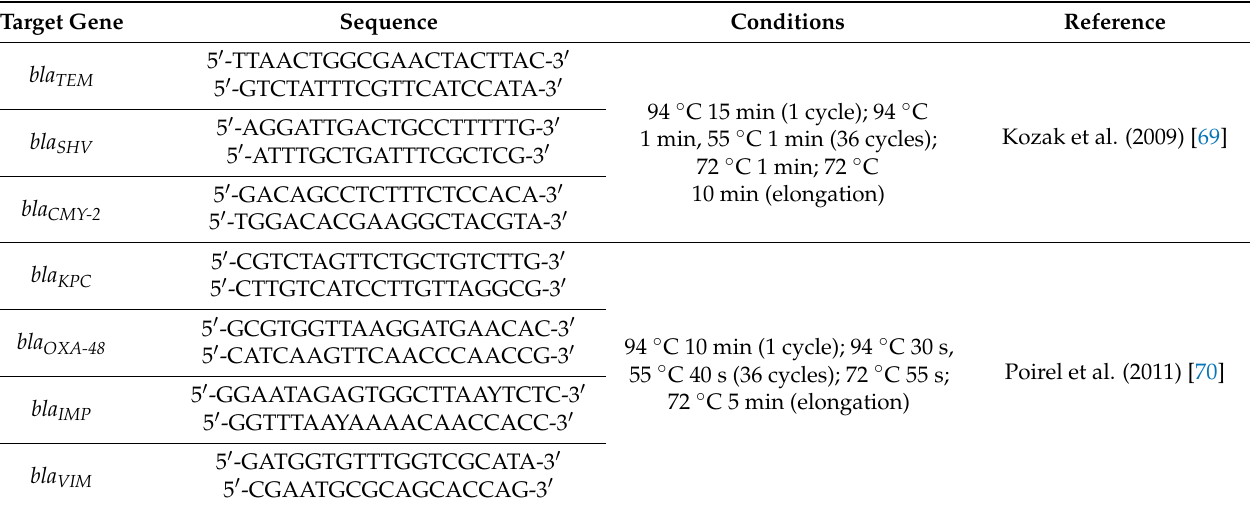
Table 5. PCR primer sequences, targets, and